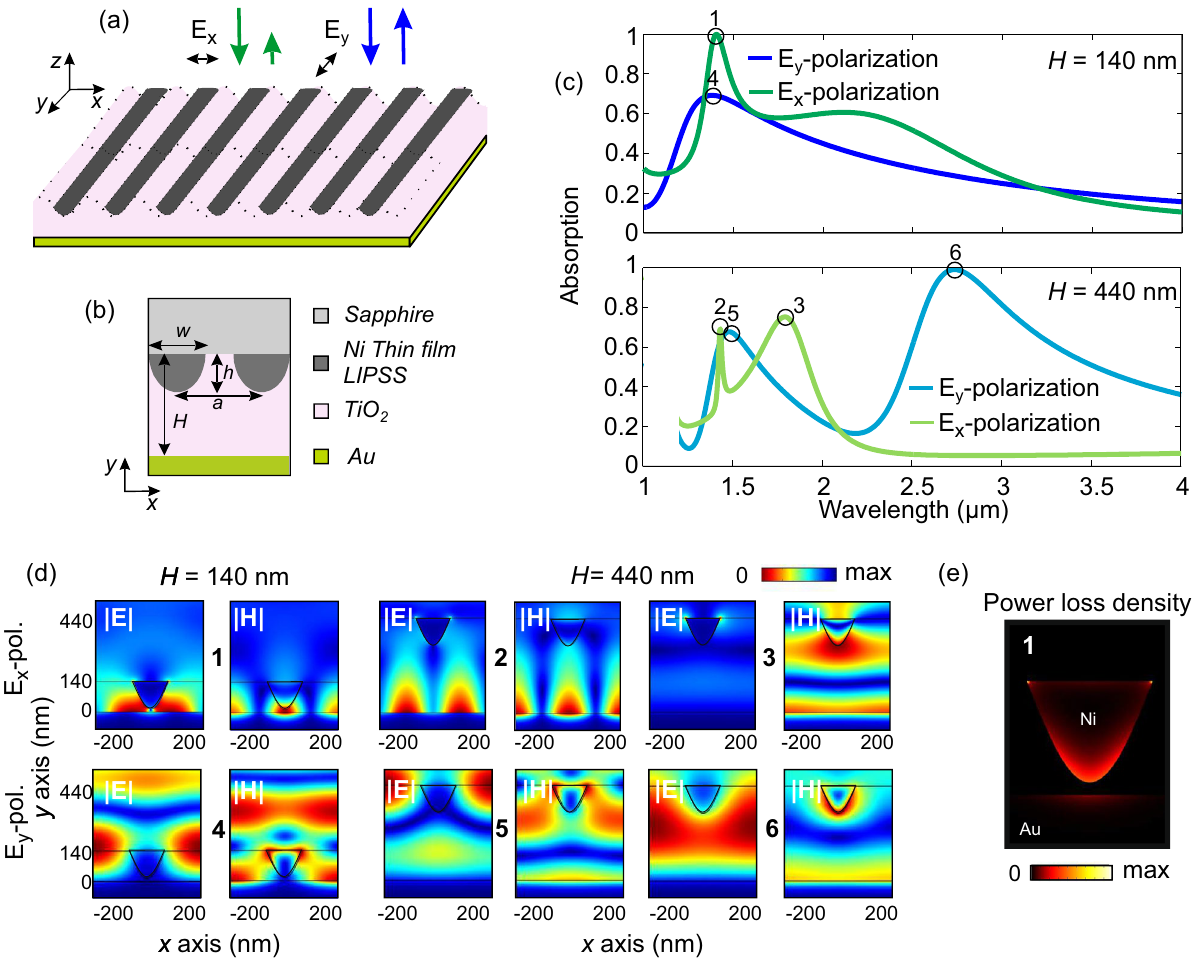
Figure 3. ( a ) Schematic of the LIPSS imprinted plasmonic gap metasurfaces and principle of operation for the polarizer, i.e., polarization sensitive perfect absorption, green arrows present the x polarization and blue arrows the y polarization. ( b ) Dimensions definition in the LIPSS imprinted metasurface. ( c ) Absorption spectra under normal incidence for two LIPSS imprinted, metal-insulator-metal, plasmonic gap metasurfaces of different insulating cavity thickness, one thinner with thickness H = 140 nm (top panel) and one thicker with thickness H = 440 nm (bottom panel) in the wavelength range (cid:31) = [1–4] μm for both polarizations, i.e., the electric field being normal to the top layer nanowires, E = E x (dark- and light-green) and the electric field being parallel to the top layer nanowires E = E y (dark- and light-blue). ( d ) Distribution of the scattered absolute values of the electric and magnetic field in the selected wavelength points of the spectral response, points 1 to 6, for both polarizations shown in ( c ). Notice that the y -coordinate starts at y = 0 , at the interface between the gold layer and the dielectric layer and increases towards the Ni nanowire. ( e ) Distribution of the power loss density showing the plasmonic losses predominately in the Ni nanowire and then in the Au